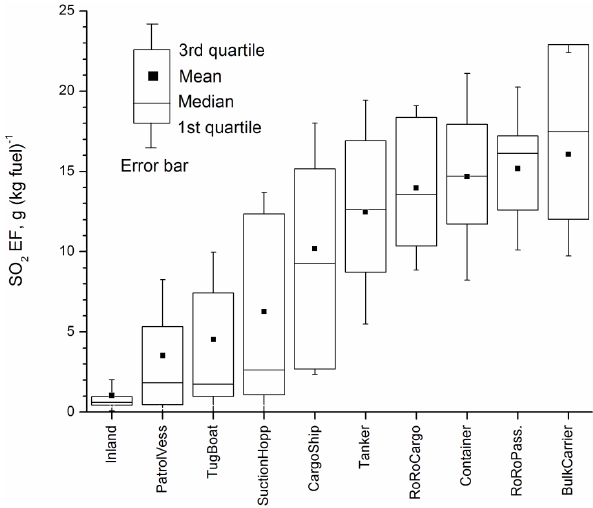
Figure 9. SO 2 EF distribution among duty type of the ships. 1008 Fig. 9. SO 2 EF distribution among duty type of the ships.